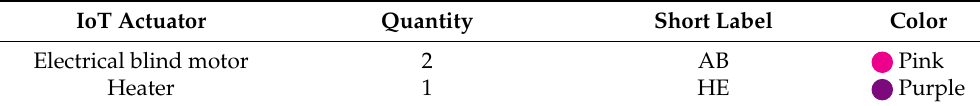
Table 5. IoT actuators used in Smart Office scenario with short label and color.